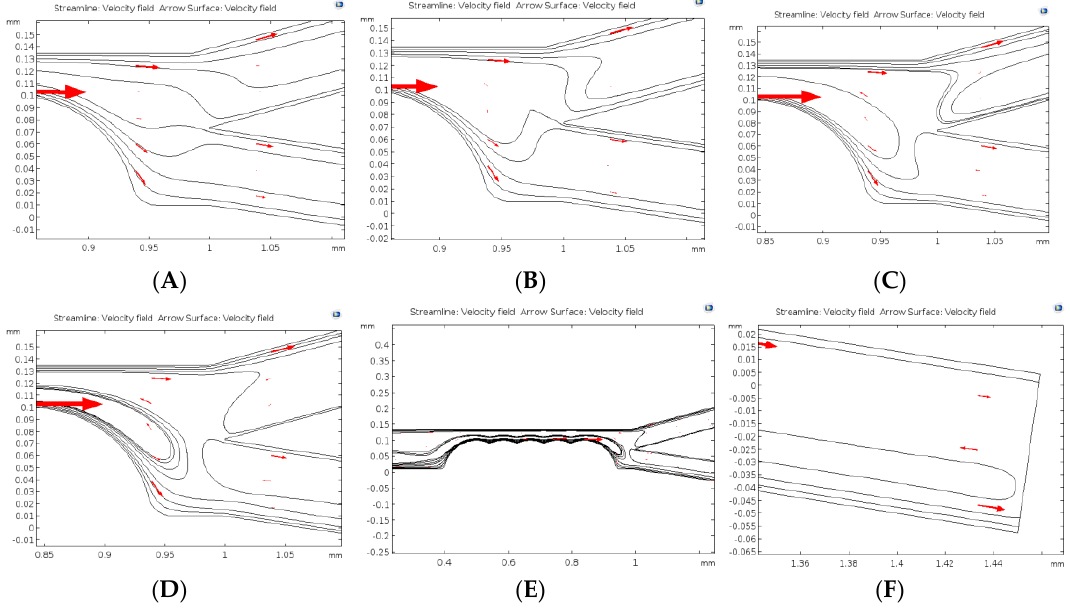
Figure 9. Velocity streamlines at various applied DC voltage conditions at fixed number of constrictions (5) and constriction size (100 µm); ( A ) and ( B ) shows streamlines at 60 V DC and 100 V DC respectively; ( C ) partial recirculation observed at 120 V DC ; ( D ) increasing recirculation at 200 V DC ; ( E ) shows the recirculation effects that caused non-compliant behavior of cells to the DEP force; and ( F ) close-up of some cells that tend to reach the exit showing recirculation as well.